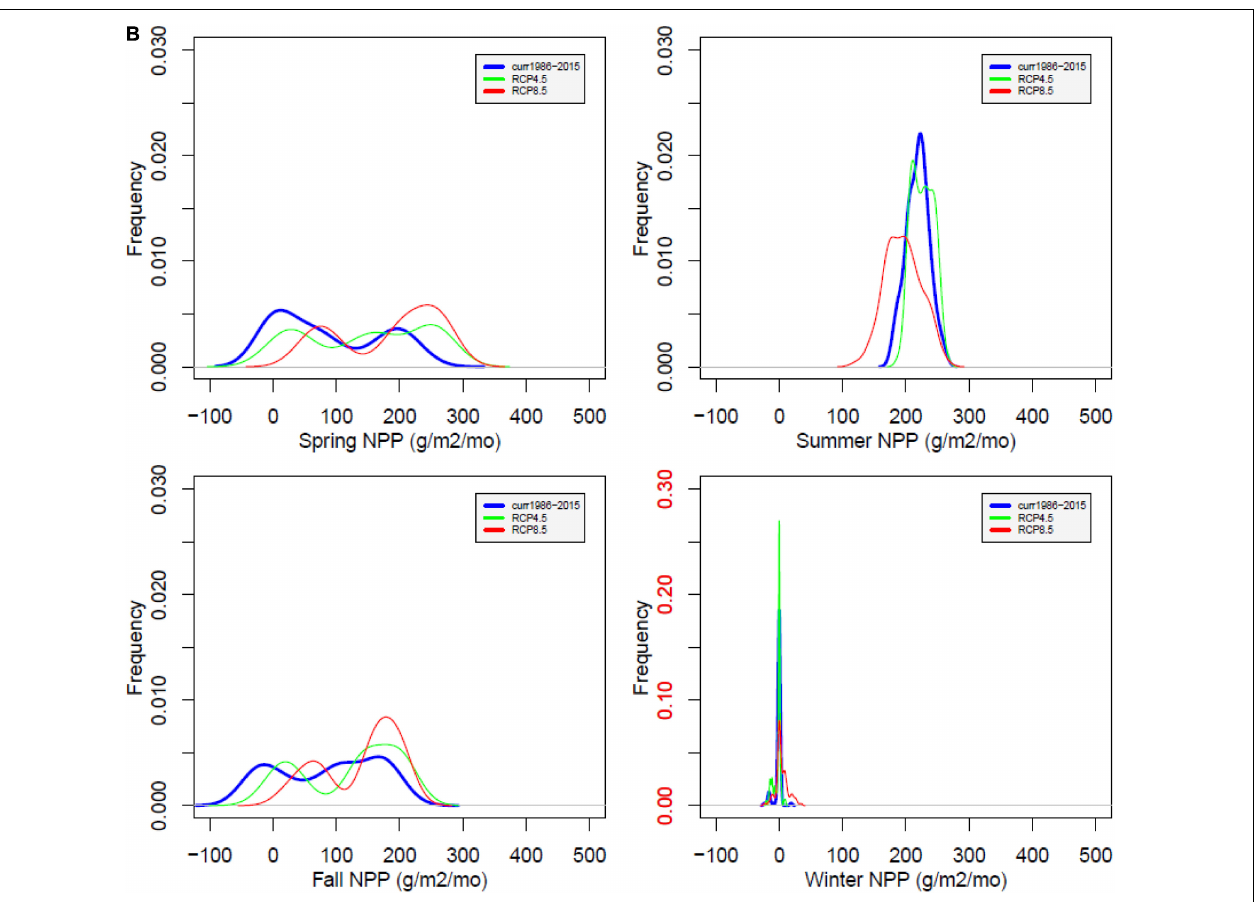
FIGURE 6 | Probability distribution of simulated net primary productivity (NPP) at WS18 (A) and WS27 (B) under future climate compared to values under current climate by season. Current (blue), RCP4.5 (green), and RCP8.5 (red). The red color of the labels in winter shows different range of y -axis compared to the other